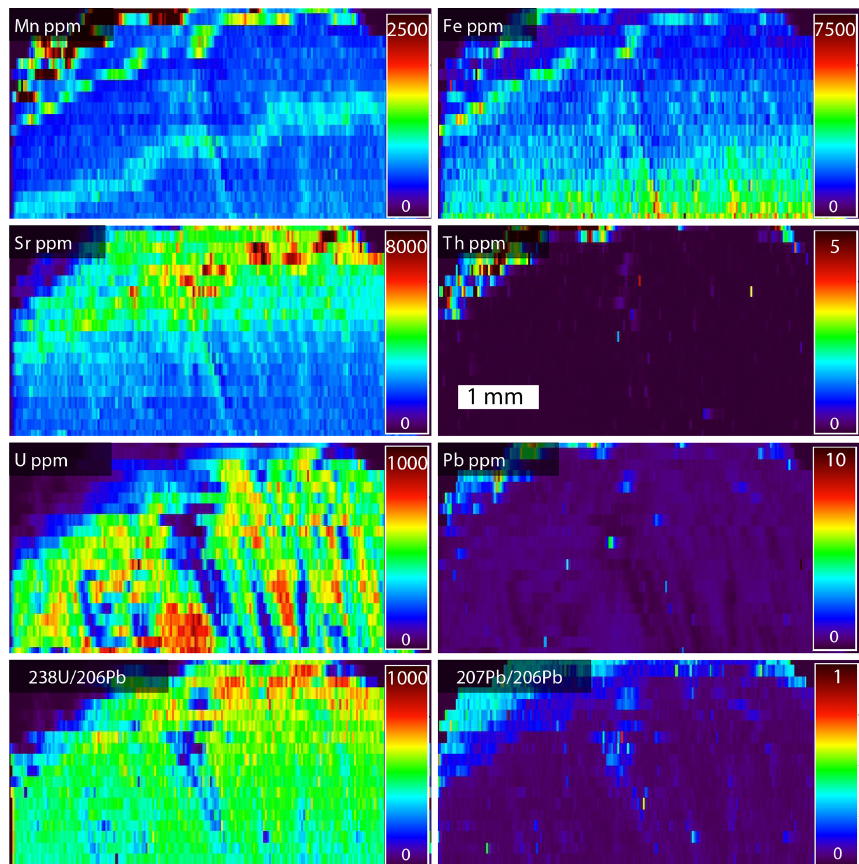
Figure 20. Laser ablation ICPMS map of the Turkana Basin Wood (TBW) dolomite. The mapped area is from near the box shown in the slab on Fig. 18. The area mapped is approximately 5mm wide. U is high concentration, while Pb and Th are low concentration. The U / Pb ratio is very